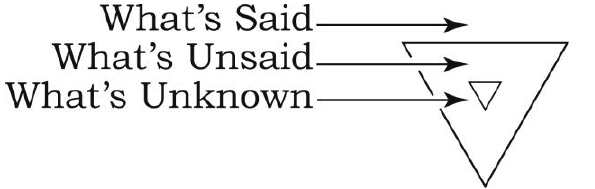
Figure 16: The Talking Level TA Teaching Diagram.